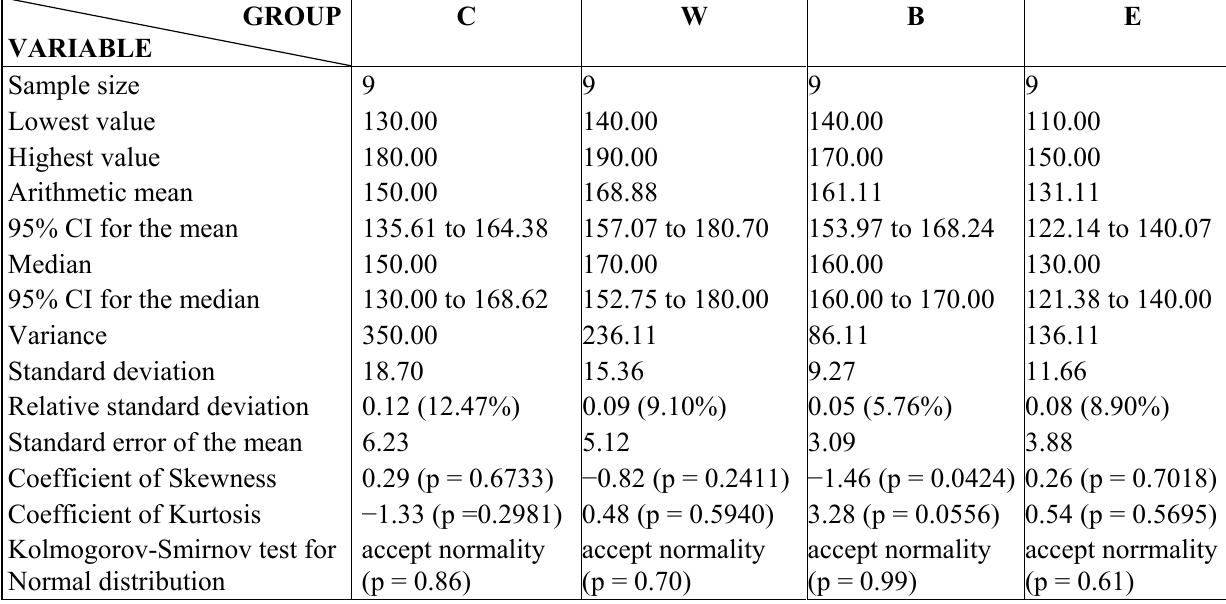
Table 1. Minimum current strength ( μ A) necessary for threshold after-discharge: summary statistics.